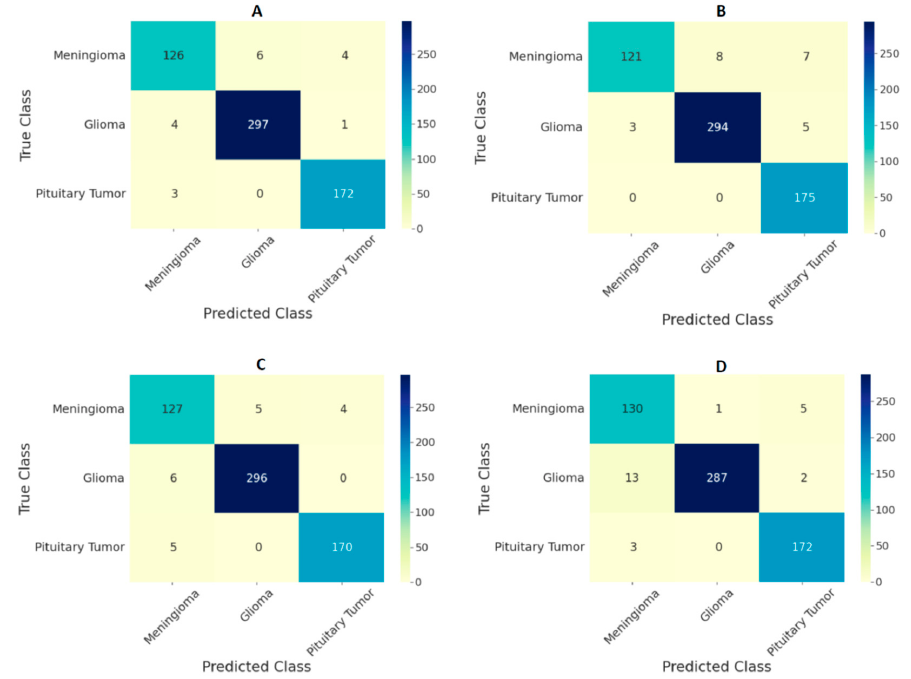
Figure 4. Confusion matrix for classification of three types of tumors on the test set using ViT models